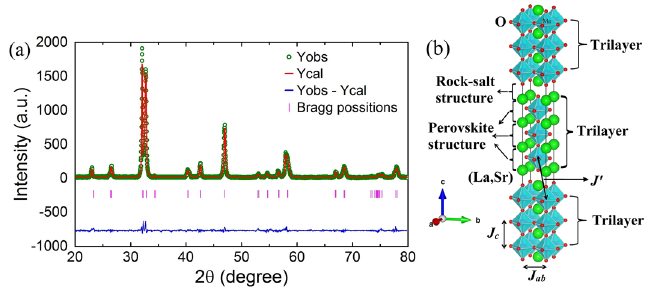
Figure 1. ( a ) Rietveld refinement of the single phase TL-LSMO-0.3 (OriginPro 2015 software) and ( b ) Unit cell crystal structure of the tri-layer TL-LSMO-0.3 (VESTA software https:// jp- miner als. org/ vesta/ en/). The MnO 6 octahedra in the crystalline bulk are denoted in cyan color. Different atoms are shown as the spheres of different [(La, Sr)—light green, Mn—blue and oxygen—red]. The perovskite structure ABO 3 , [A → (La, Sr) and B → Mn] consist of a MnO 6 octahedra in the center and (La, Sr) atoms lies at the corner of the perovskite